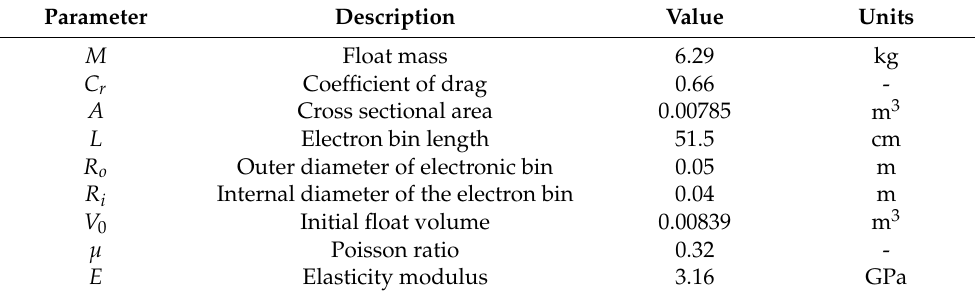
Table 1. Float dynamic